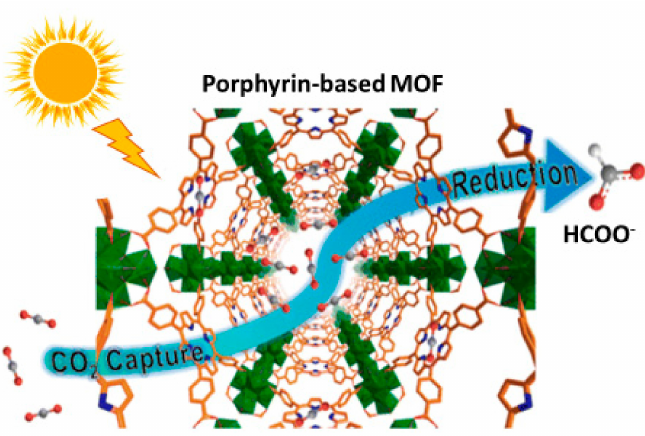
Figure 11. The activity of porphyrin-based MOF towards CO 2 capture and reduction. Adapted and reprinted with permission from [230], Copyright (2015) American Chemical